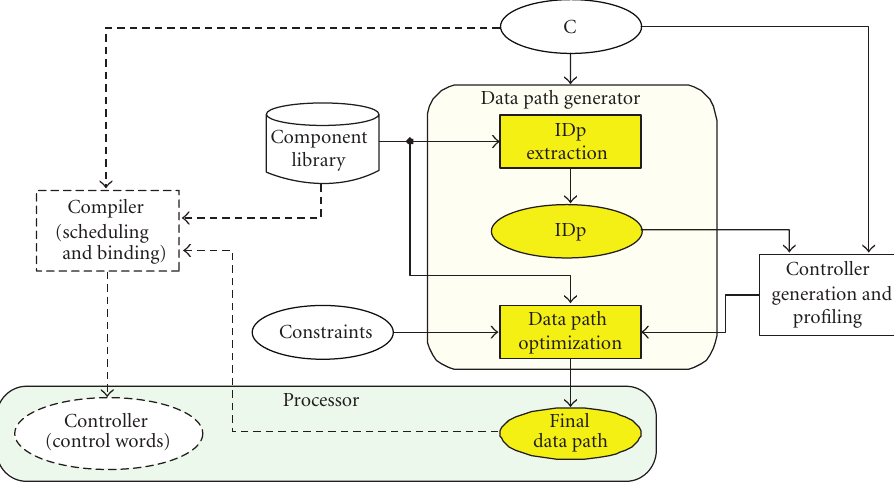
Figure 3: Data path extraction